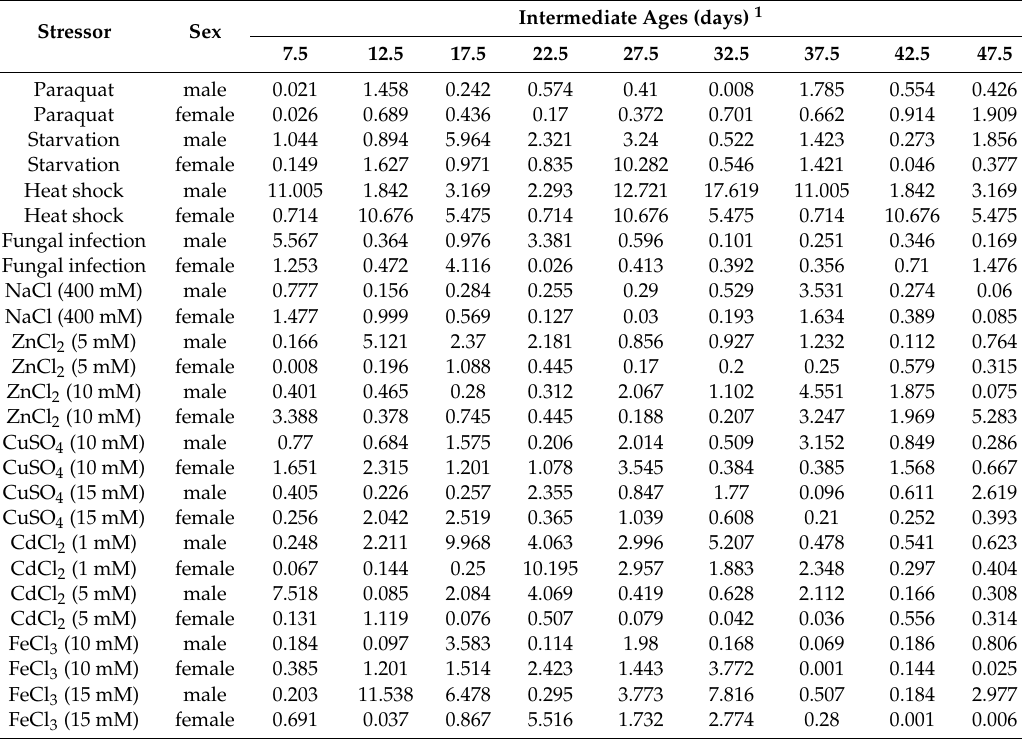
Table 1. The table with the values of the deviation of virtual age estimation for all variants of the experiment shows the age prediction